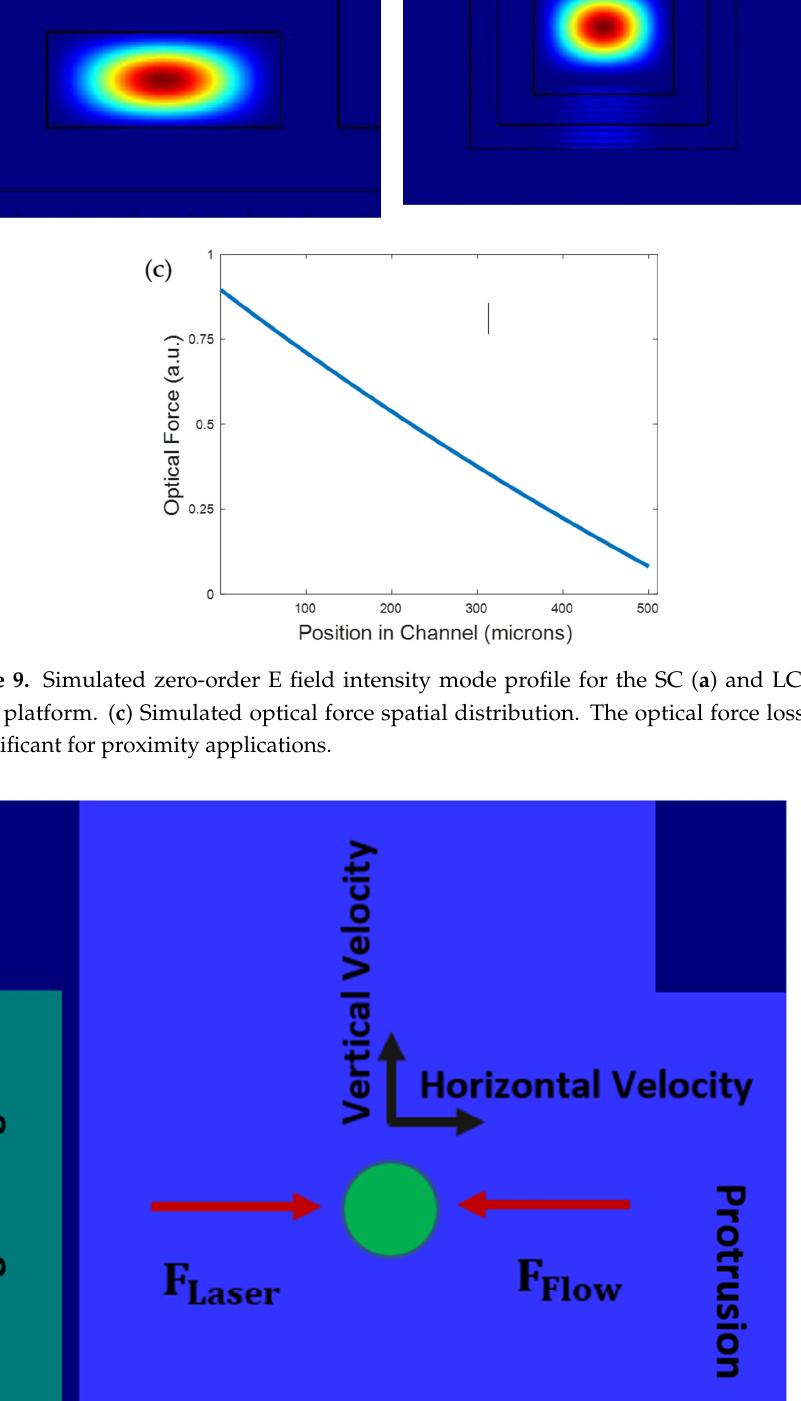
sion. The simulation parameters are not based on experimental data. Smaller particles re- quire more optical power to be pushed into the protrusion cavity and become trapped due to their limited surface area. The higher the liquid flow velocity, the more power is required to trap particles.